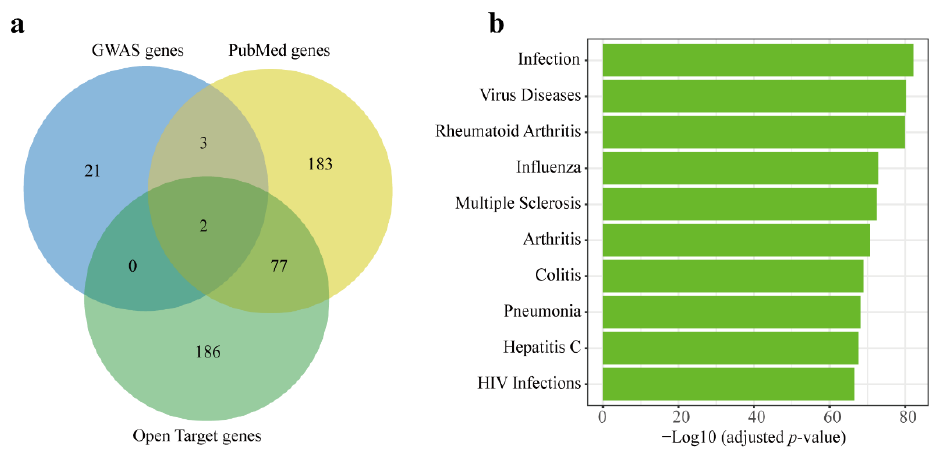
Figure 3. ( a ) Data source of COVID-19 genes. Venn diagram showing the overlap among the genes associated with COVID-19 identified using the GWAS (GWAS genes) and text mining methods (PubMed genes and Open Target genes). ( b ) Enrichment analysis of the COVID-19-associated genes using DisGeNET.